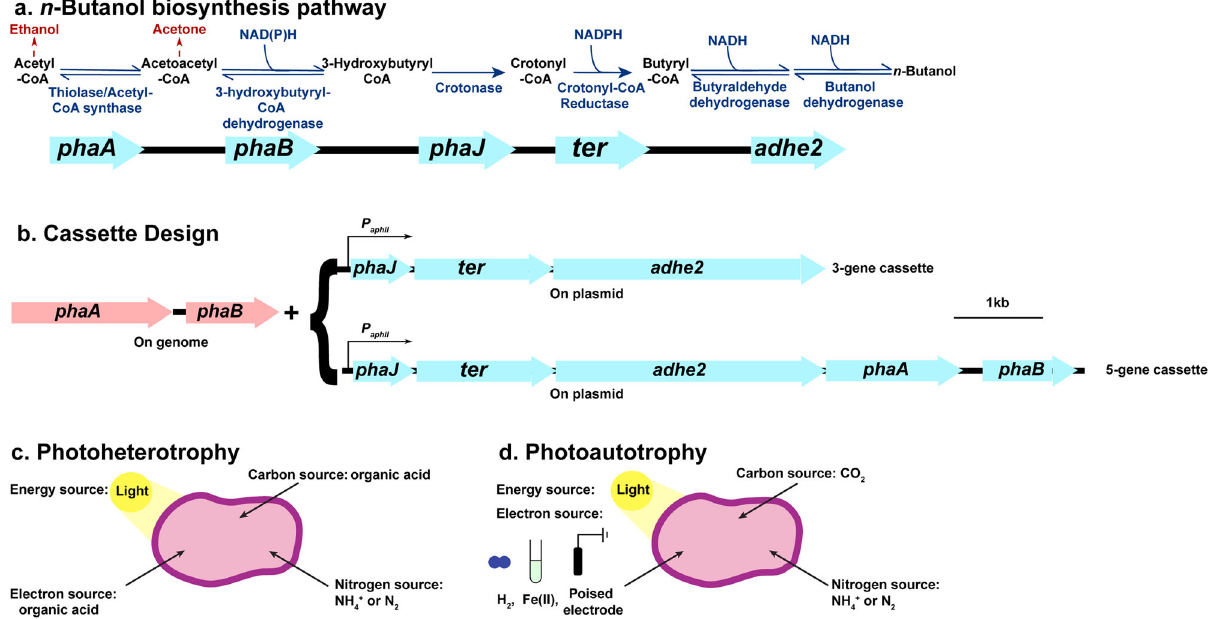
Fig. 1 n -Butanol biosynthesis pathway, cassette design, and major metabolisms used for n -butanol production in Rhodopseudomonas palustris TIE-1 (TIE-1). a n -butanol biosynthesis pathway involves fi ve genes. The enzymes encoded by each gene and the reactions catalyzed by these enzymes are shown in dark blue. Two major byproducts (acetone and ethanol) are shown in dark red. NADH, nicotinamide adenine dinucleotide; NADPH, nicotinamide adenine dinucleotide phosphate. b Cassette design. The 3-gene cassette relies on phaA and phaB on the genome of TIE-1 for the fi rst two steps of n -butanol synthesis. Here, only 3-genes ( phaJ , ter , and adhE 2) were introduced on a plasmid under a constitutive promoter P aphII . The 5-gene cassette has all fi ve genes ( phaA , phaB , phaJ , ter , and adhE 2) on the plasmid under a constitutive promoter P aphII . c Photoheterotrophy: TIE-1 uses organic acids as carbon and electron source, light as an energy source, and ammonium (NH 4 + ) or dinitrogen gas (N 2 ) as a nitrogen source. d Photoautotrophy: TIE-1 uses carbon dioxide as carbon source, hydrogen (H 2 ), ferrous iron [Fe(II)], or poised electrode as an electron source, light as an energy source, and NH 4 + or N 2 as a nitrogen